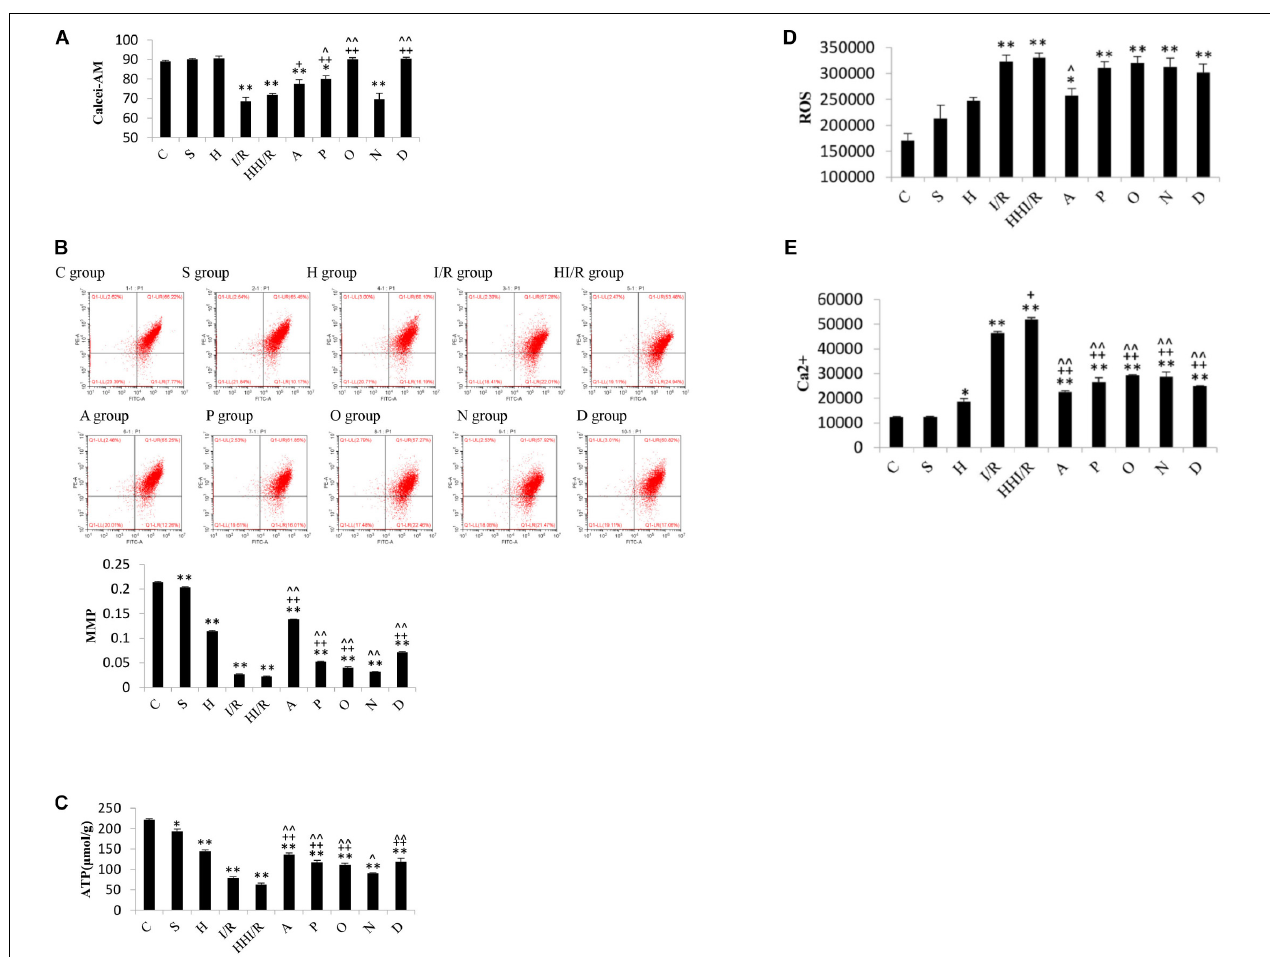
FIGURE 7 | Changes of MPTP, MMP, ATP, ROS, and Ca 2 + levels in rats 24 h after I/R or not. (A) Calcei-AM levels evidently decreased in I/R and HI/R groups compared to control group, and increased significantly by P, O, and D groups ( n = 3, P < 0.05 or 0.01). (B) MMP levels in I/R and HI/R groups significantly decreased compared to control groups, especially in the latter, and evidently increased in A, P, O, and D groups than that in HI/R group and I/R group ( n = 3, P < 0.01). (C) The ATP levels in I/R and HI/R groups significantly decreased compared to control groups, especially in the latter, and evidently increased in A, P, O, and D groups than that in HI/R group and I/R group ( n = 3, P < 0.01). (D) ROS levels increased significantly in I/R or HI/R than that in control groups ( P < 0.01). (E) Ca 2 + levels in I/R and HI/R groups significantly increased compared to control groups, especially in the latter, and evidently decreased in A, P, O, N, and D groups than that in HI/R group and I/R group ( n = 3, P < 0.01). ∗∗ or ∗ means P < 0.01 or 0.05 versus control, ++ or + means P < 0.01 or 0.05 versus I/R group, and ∧∧ or ∧ means P < 0.01 or 0.05 versus HI/R group, analyzed by one-way ANOVA and Bonferroni post hoc